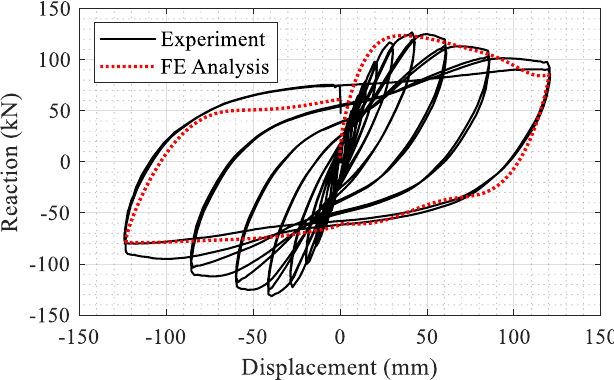
Figure 14. Comparison of experiment and finite element model results.